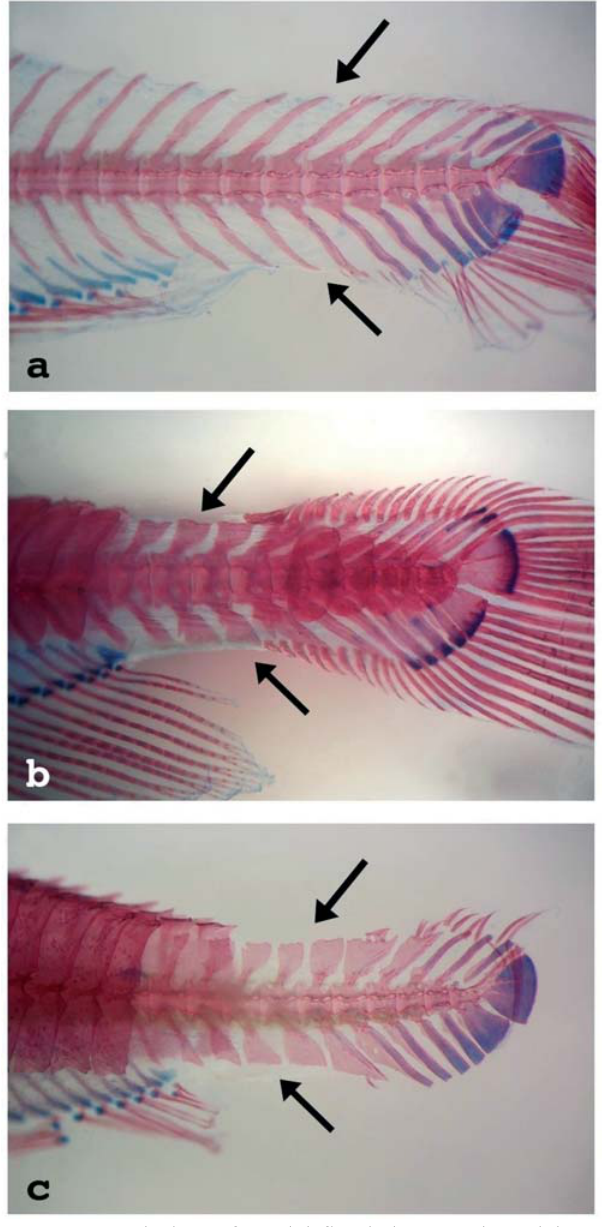
Fig. 8. Lateral view of caudal fin skeleton and caudal pe- duncle vertebrae of Physopyxis : a. P. cristata (INPA 25062, 10.99 mm SL); b. P. lyra (INPA 20321, 25.54 mm SL); and c. P. ananas (INPA 20196, 13.05 mm